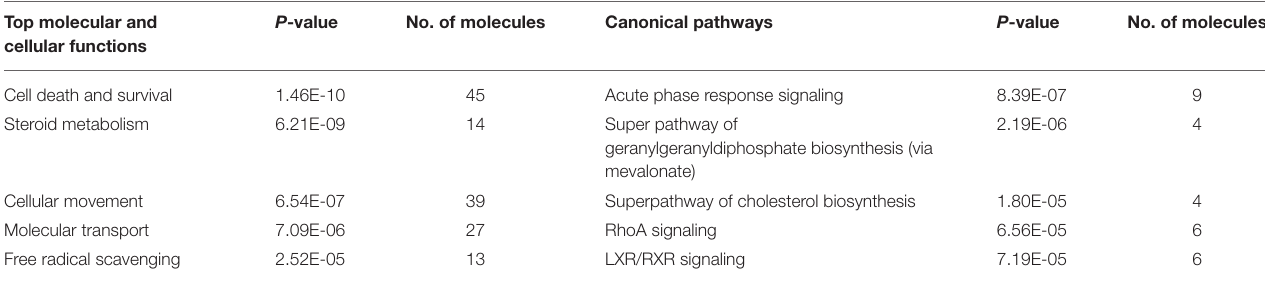
FIGURE 4 | IPA depicting (A) networks integrating proteins involved in cell death and survival, cell migration, the scavenging of reactive oxygen species, and lipid metabolism and (B) upstream regulators of differentially abundant proteins in the CL. Red and green colors depict an increase or decrease, respectively, in abundance of the proteins in the CL. The color intensity of nodes indicates a fold change increase or decrease associated with a particular protein.